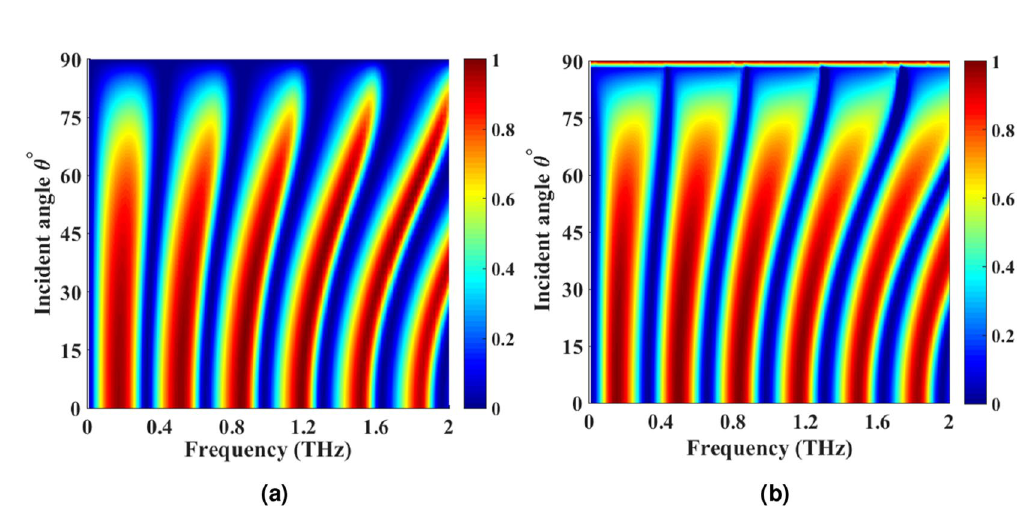
Figure 11. Absorption spectra of the tunable THz absorber of Fig.7b with oblique ( a ) TM and ( b ) TE polarized incident wave obtained by MoL for µ c ( CGS ) = 0.25 eV, µ c ( PAGS ) = 0.125 eV, τ = 0.1 ps and T = 300